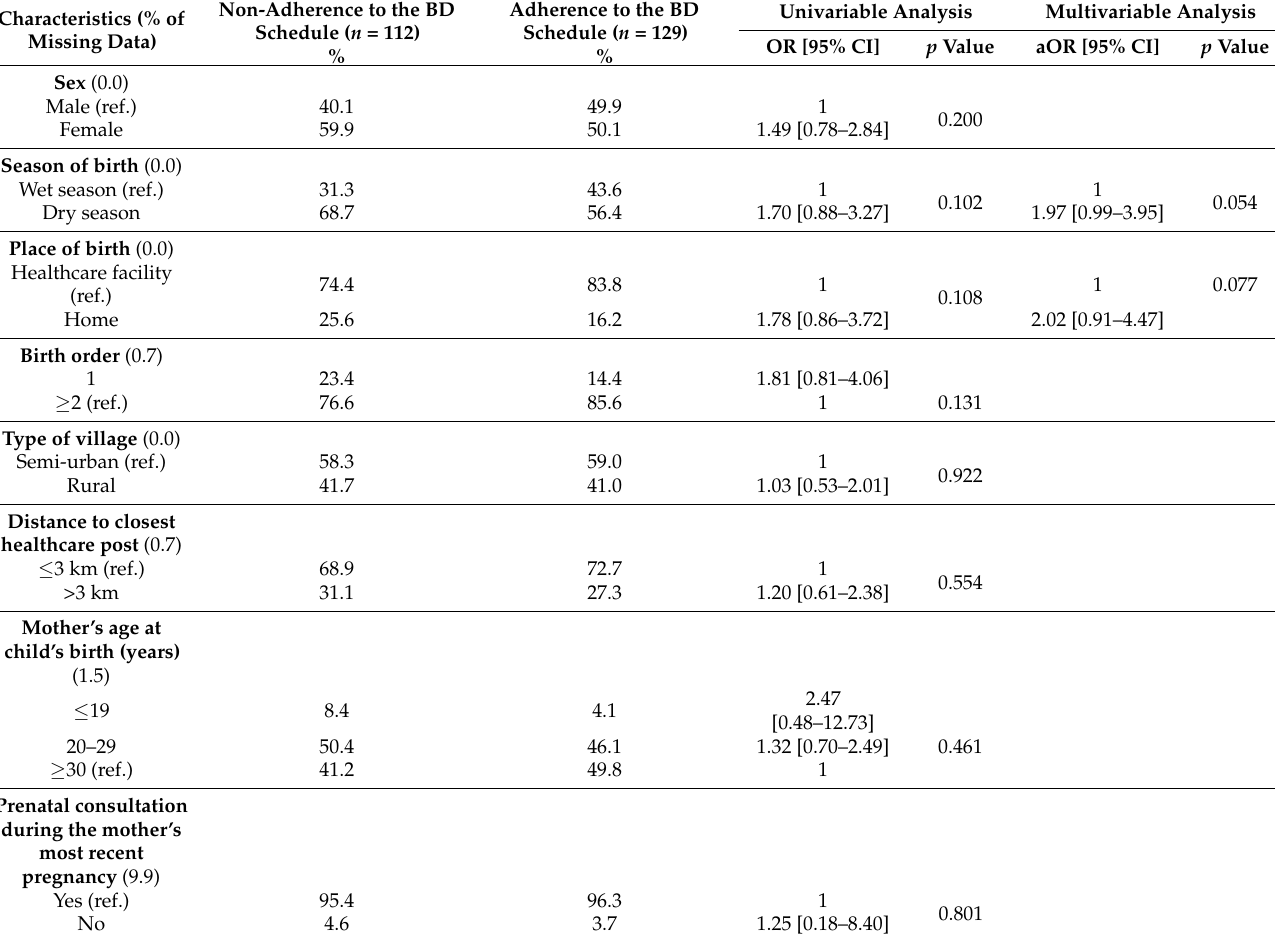
Table 2. Factors associated with non-adherence to the hepatitis B virus (HBV) birth dose (BD) schedule in children born on or after 1 January 2016 living in the mostly rural area of Niakhar ( n = 241 children participating in the ANRS 12356 AmBASS survey with available vaccination data, logistic regression models using weighted and calibrated